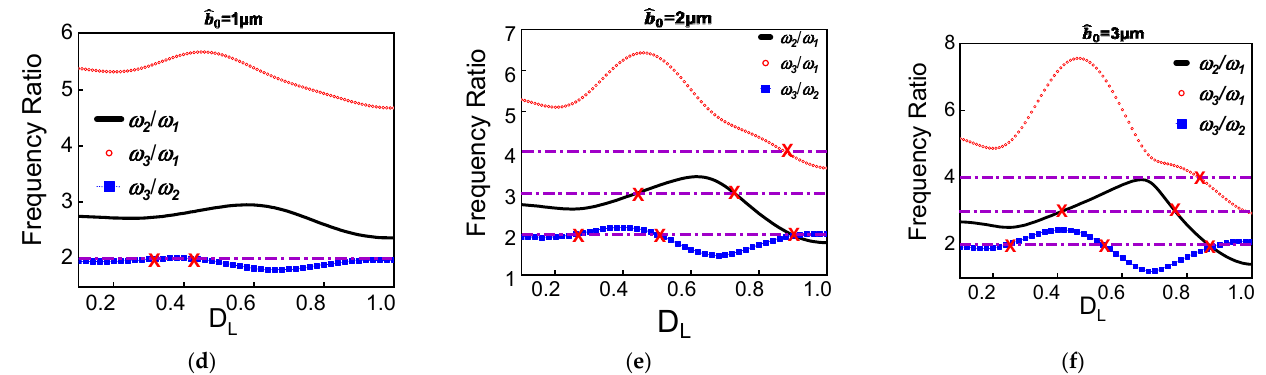
Figure 3. Variation of the three lowest natural frequencies of the proposed hybrid curved beam with dome length. ( a ) The first symmetric natural frequency. ( b ) The first antisymmetric natural frequency. ( c ) The second symmetric natural frequency. ( d – f ) Variation of ratios between different modes with the dome length for various initial rises. ( d ) ˆ b 0 = 1 µ m. ( e ) ˆ b 0 = 2 µ m. ( f ) ˆ b 0 = 3 µ m. As tuning the dome length, different commensurate ratios between modes could be achieved. The above is a necessary condition for activating the nonlinear coupling between different modes via internal resonance. The D L axis starts from 0.1. The red crosses are associate with the dome length at which we have commensurate ratios.